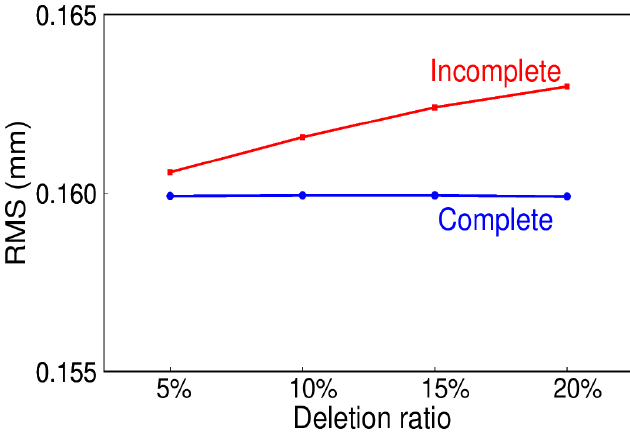
Figure 15. RMS for the signal extracted and the simulated.